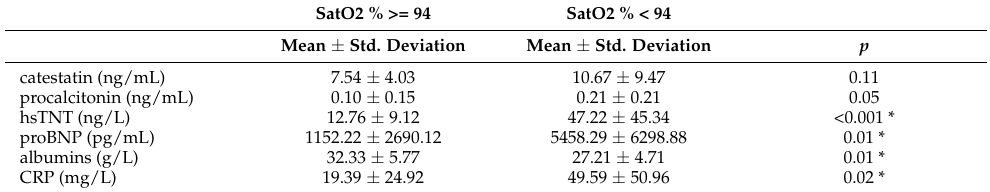
Table 4. Differences between participants with hemoglobin oxygen saturation > 94% ( n = 18) and <94% (n = 14) in CST and cardiovascular and inflammatory parameters (Student’s t -test, one-tailed). SatO2 % >= 94 SatO2 % < 94 Mean ± Std. Deviation Mean ± Std.